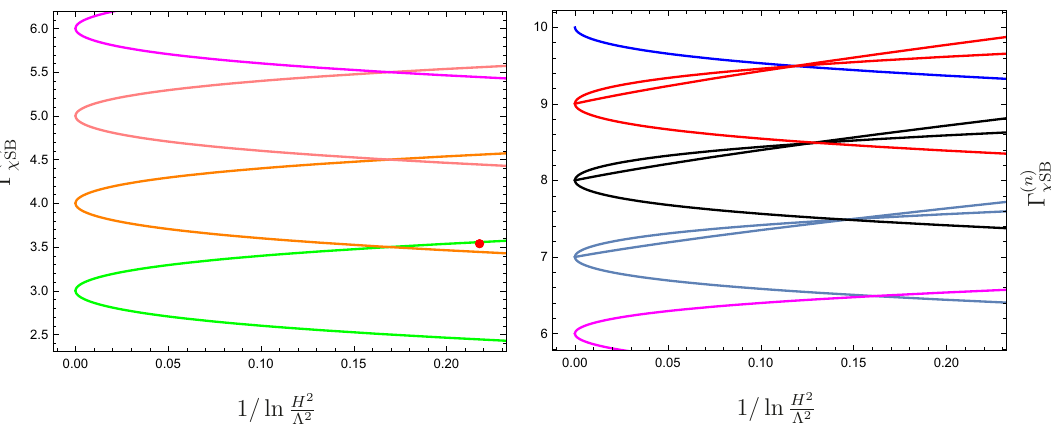
Figure 6 . Leading order correction to the conformal spectra for the chiral symmetry breaking fluctuations at higher n . Note that the (perturbative) coalescence of various sub-branches is quite generic. The red dot (the left panel) is a replot of the red dot from figure